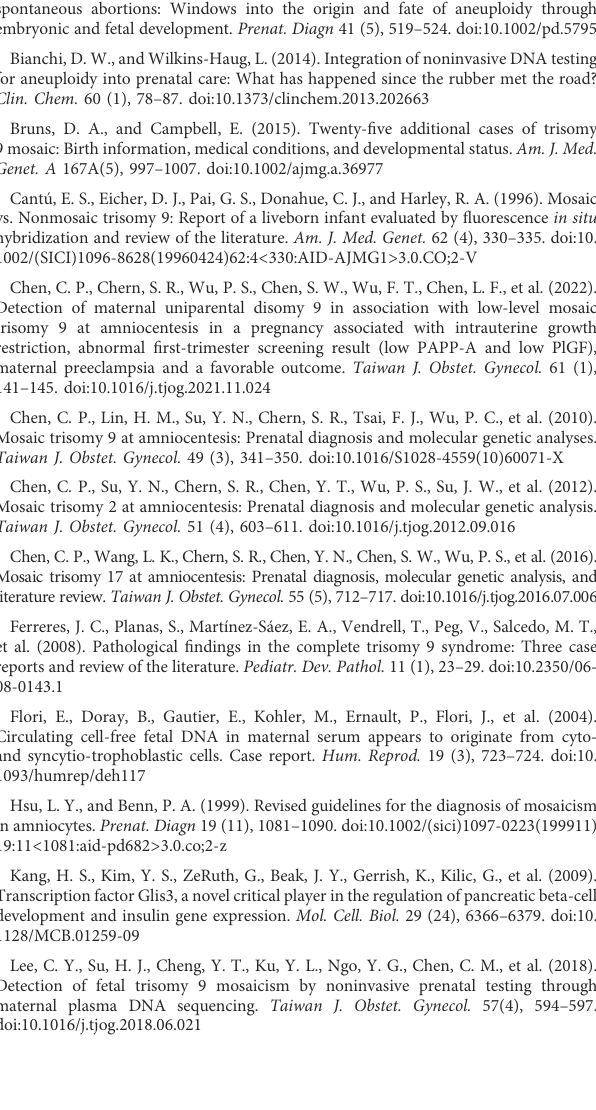
and the black box represents the centromere (x-axis: chromosomes 9; y-axis: copy number). SUPPLEMENTARY FIGURE S2 CNV-seq pro fi les of Case 1 for multiple samplings showed various levels of trisomy9.CNV-seqpro fi lesareshownforuterus,lung,kidney,heartandskinof Case1 with 60%, 35%, 20% and 10% trisomy 9 mosaicism and normal result, respectively.Thebluelinerepresentsthemeancopynumberandtheblackbox represents the centromere (x-axis: chromosomes 9; y-axis: copy number). SUPPLEMENTARY FIGURE S3 CNV-seq pro fi les of Case 2 for multiple samplings showed various levels of trisomy 9. CNV-seq pro fi les are shown for uncultured amniotic fl uid,